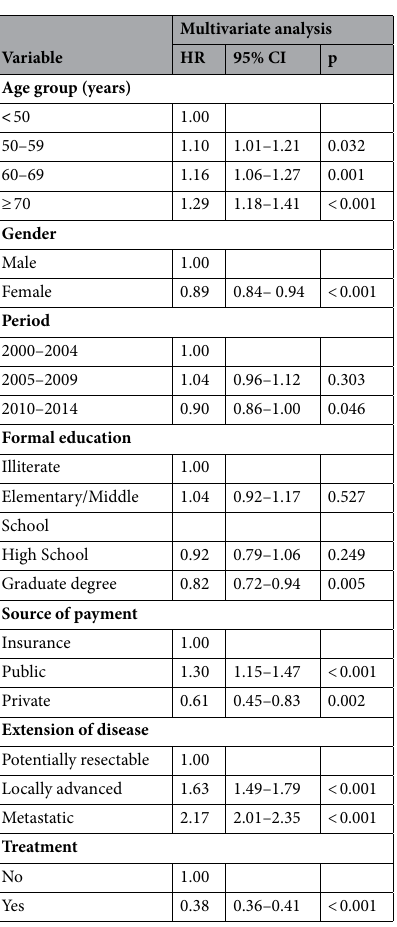
Table 4. Cox proportional hazard regression for overall survival (multiple imputation of missing data; N =